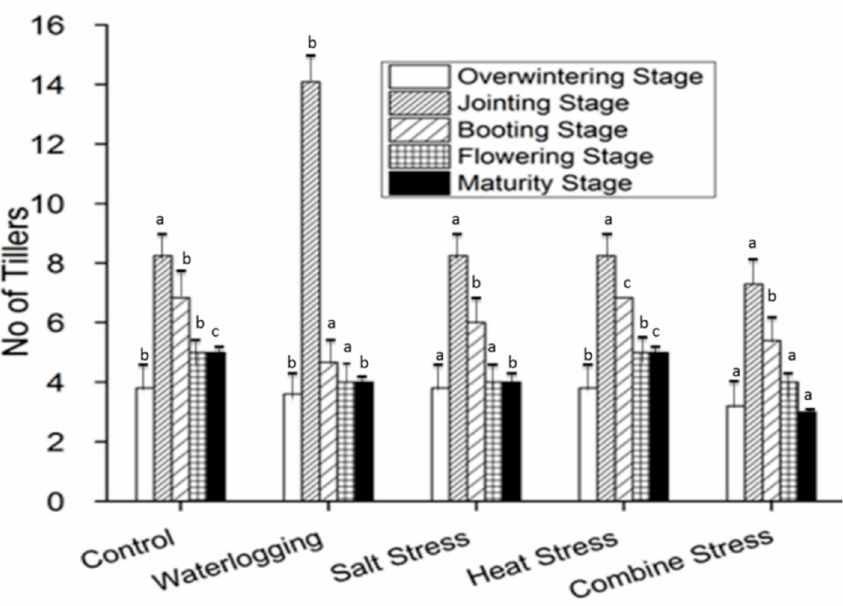
Figure 2. Number of tillers during five-stage growth of wheat plants grown under different abiotic stresses. Reported values are the means and standard deviations of triplicates for each treatment. Note: sampling date at overwintering stage was 28 December 2020; at jointing stage was 12 March 2021; at booting stage was 30 March 2021; at the flowering stage was 17 April 2021; and at maturity stage was 28 May 2021. Lowercase letters show the significant differences within treatments according to one-way ANOVA and DMRT, while the significance level was p ≤ 0.05.